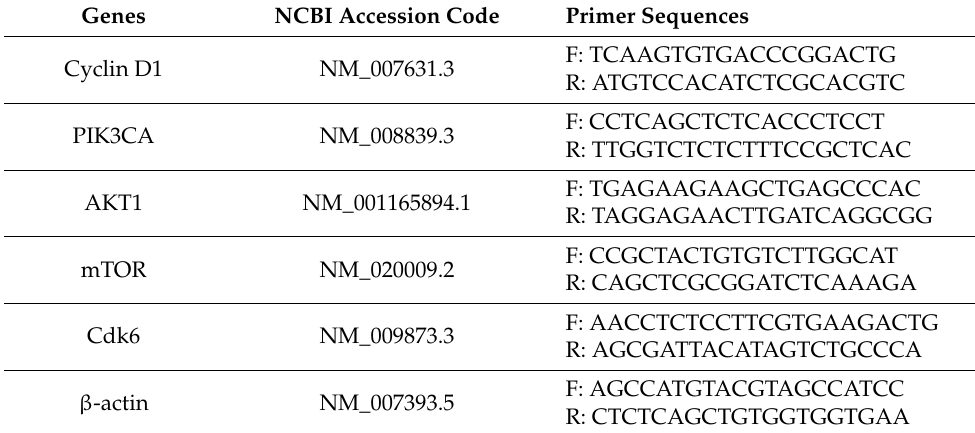
Table 1. Primer sequences for